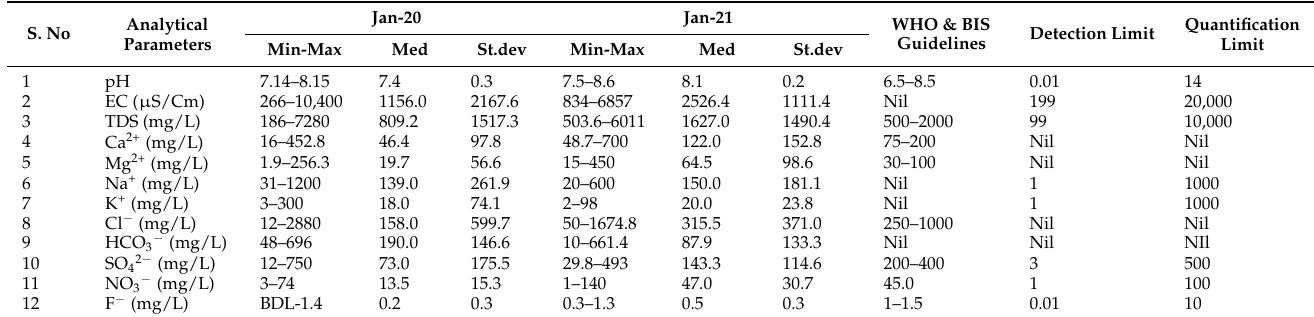
Table 1. Analytical results descriptive